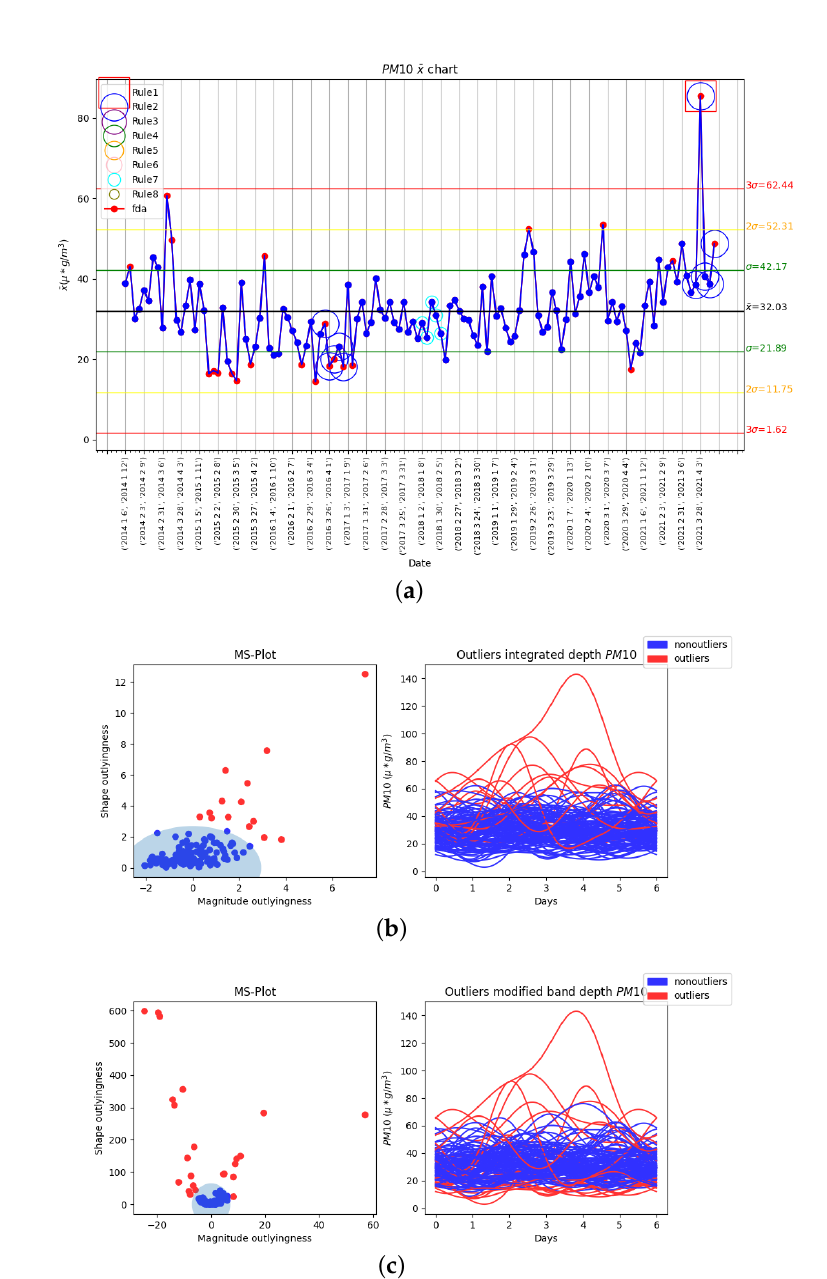
Figure 8. Results of the third phase of the PM 10 analysis: ( a ) ¯ x chart with the weekly rational subgroups of the first quarter of every year, the Nelson rules implemented, and the functional outliers detected with the modified band depth marked with red dots; ( b ) (left) Cartesian representation of the magnitude and shape outlyingness of each function with the integrated depth; (right) functional plot of the PM 10 values of each week; ( c ) (left) Cartesian representation of the magnitude and shape outlyingness of each function with the modified band depth; (right) functional plot of the PM 10 values of each